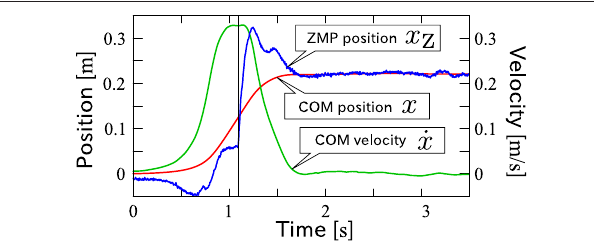
FIGURE6| Atypical timeseriesofCOMposition(redline),COMvelocity (green line) and ZMP (blue line) of step-and-brake motions. The black vertical line indicates the detected moment of foot-landing.